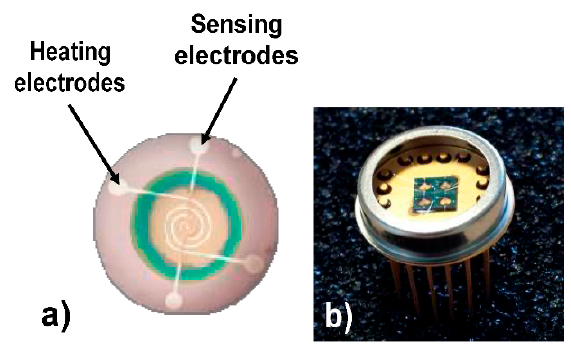
Figure 1. ( a ) top-view of the membrane; ( b ) mounted